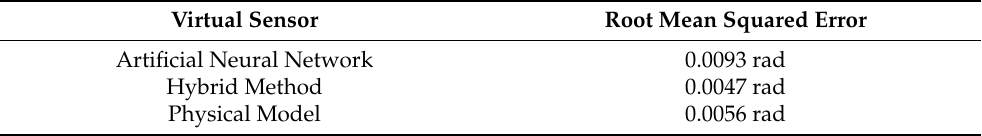
Table 3. Estimation Quality Validation.